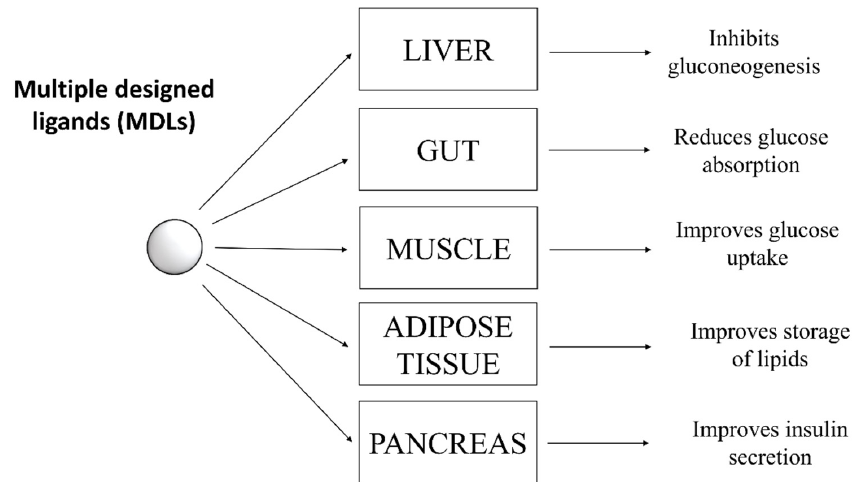
Figure 3. Antidiabetic strategy based on administration of multiple designed ligands: a single drug regulates different specific targets.